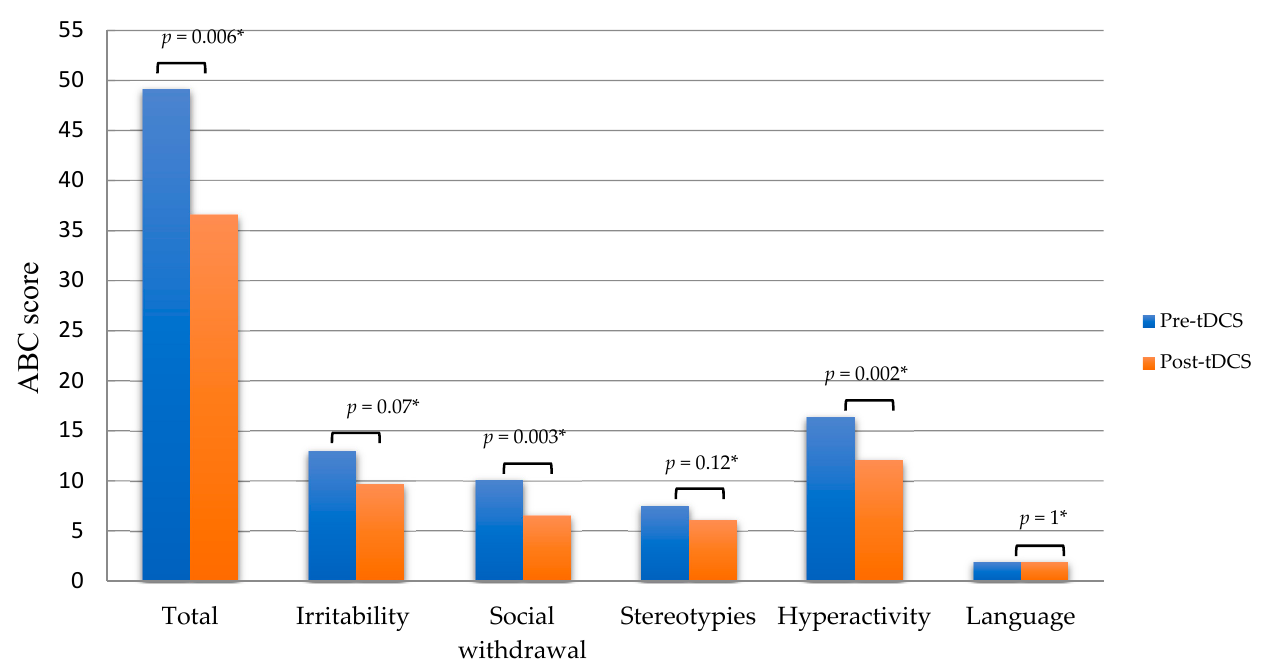
Figure 1. Aberrant Behavior Checklist mean scores before (pre-tDCS) and after (post-tDCS) transcranial direct current stimulation treatment. * Due to the low statistical power of this pilot study, no significance threshold was established, and p -values should be considered cautiously.